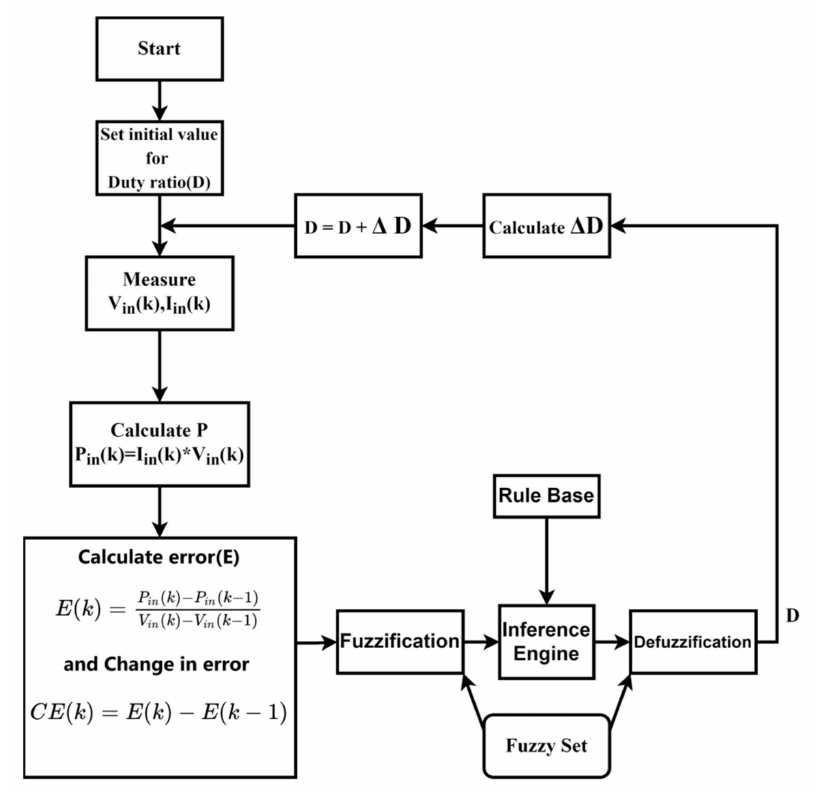
Figure 19. Flowchart of the fuzzy logic